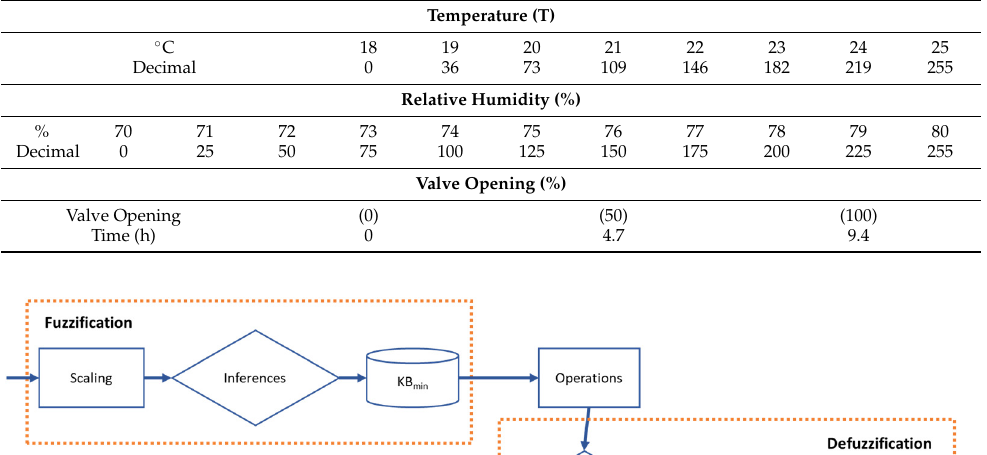
Table 1. Summary of variables in their decimal equivalent: environmental temperature (T), relative humidity (RH), and valve opening.